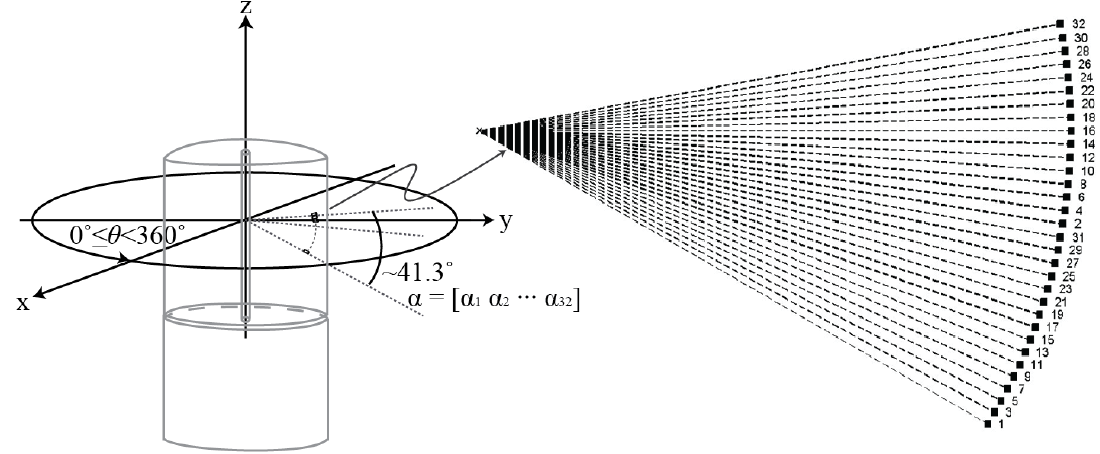
Figure 1. Thirty-two radially oriented lasers embedded inside the Velodyne HDL-32, with the modified manufacturer laser labelling.